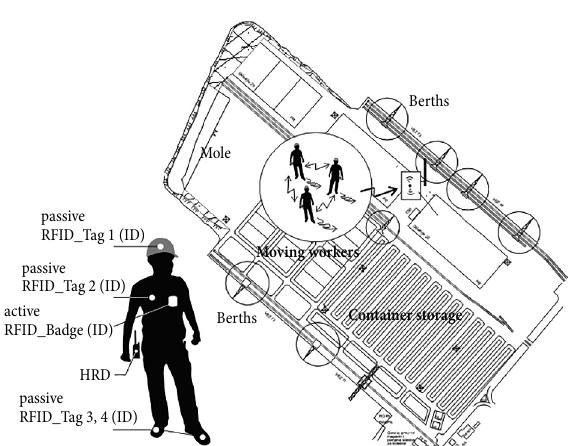
Fig. 5. An RFID occupational safety model on the layout of the Port of Bar container